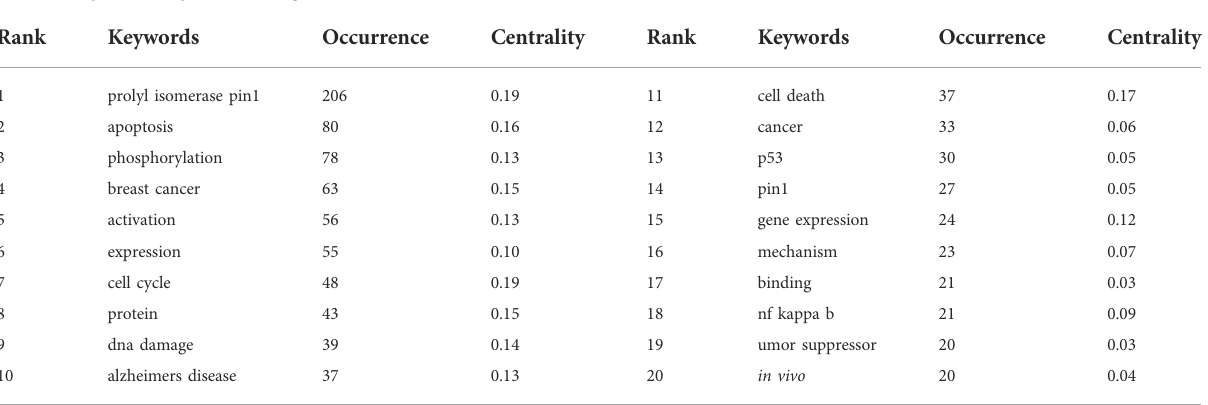
TABLE 5 Top 10 most productive